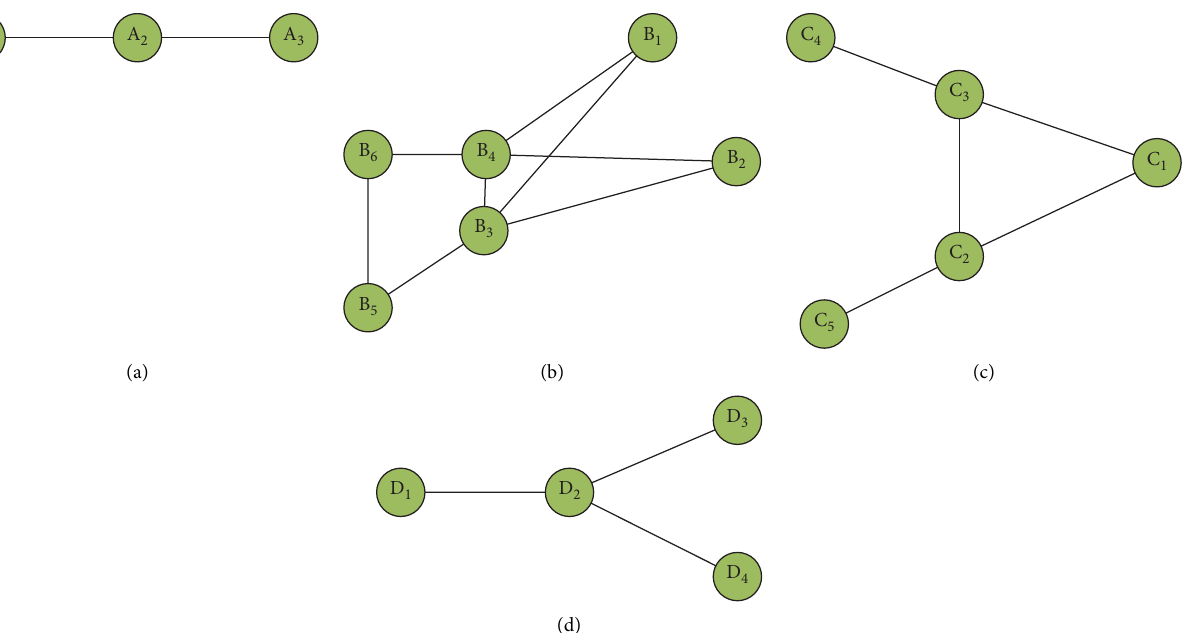
Figure 4: ASTN along diferent air routes. (a) ASTN along linear air routes. (b) ASTN along cross-air routes. (c) ASTN along convergent air routes. (d) ASTN along divergent air routes.